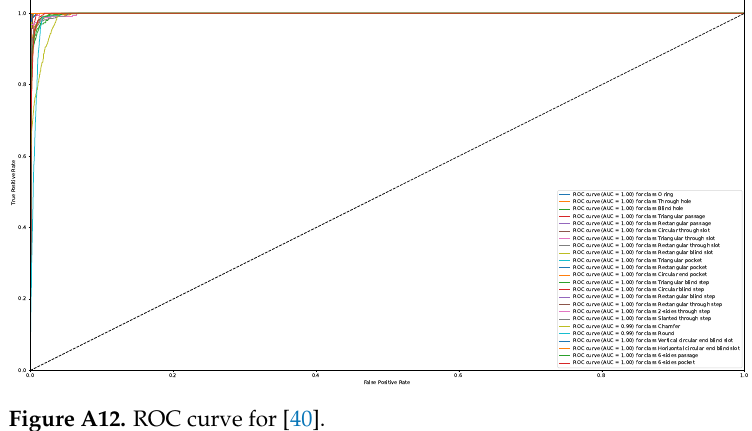
Figure A12. ROC curve for [40].